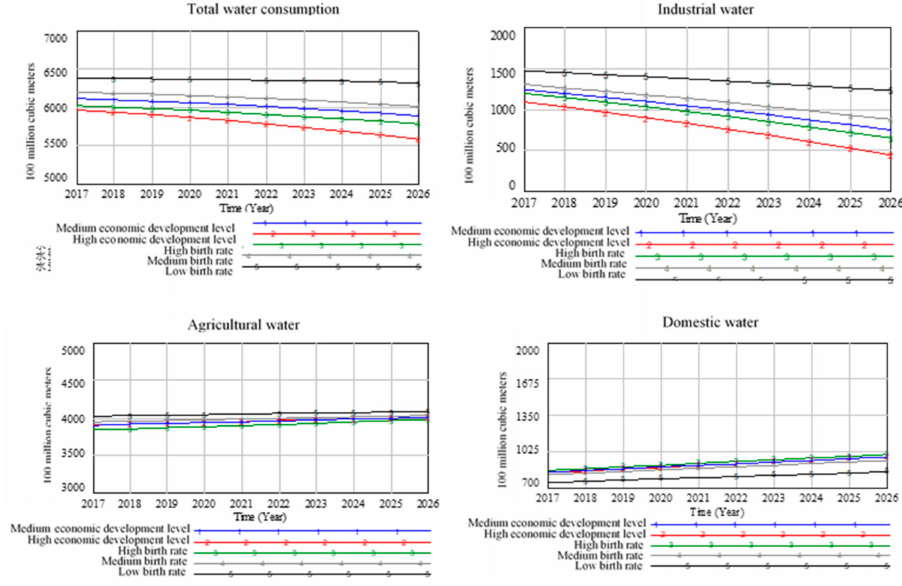
Figure 7. Scenario prediction curve of water